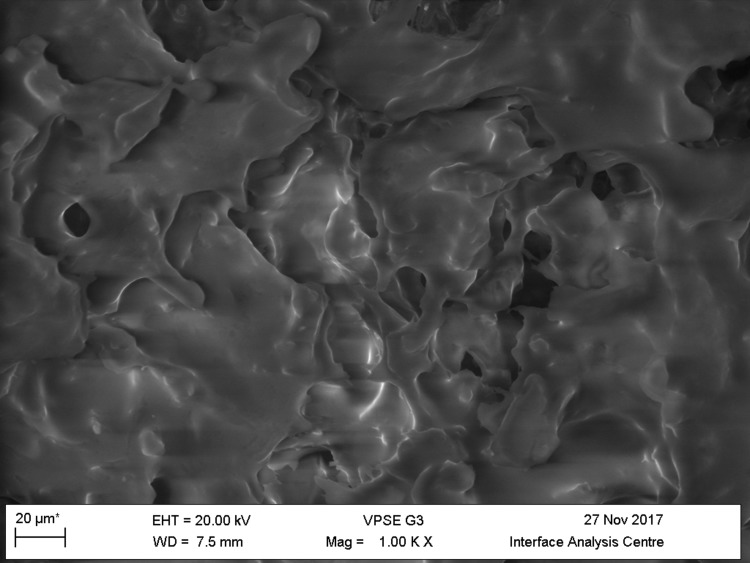
Demineralised modern chicken bone viewed close up (image 2).